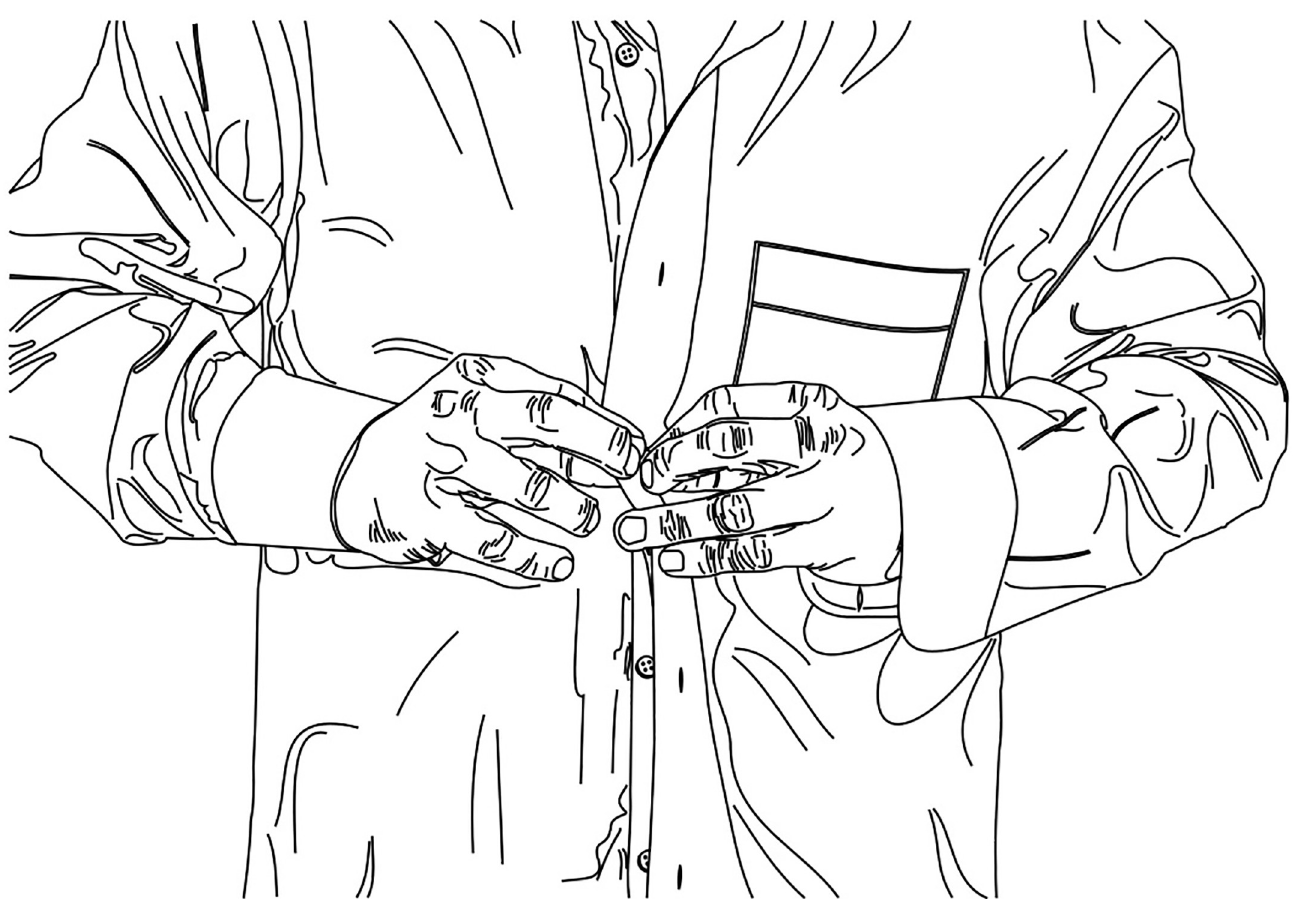
Fig 8. Functional performance. Shirt task. The standing participant picked up a folded unbuttoned long sleeve shirt and put it on as fast as possible. The test was completed when all six buttons were done-up in their corresponding holes.